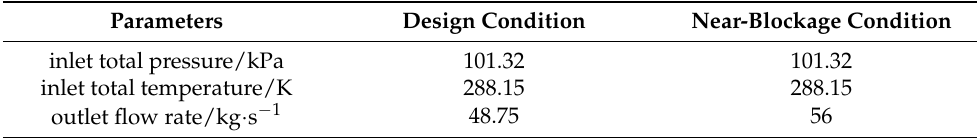
Table 2. Boundary conditions of the design condition and near-blockage condition.